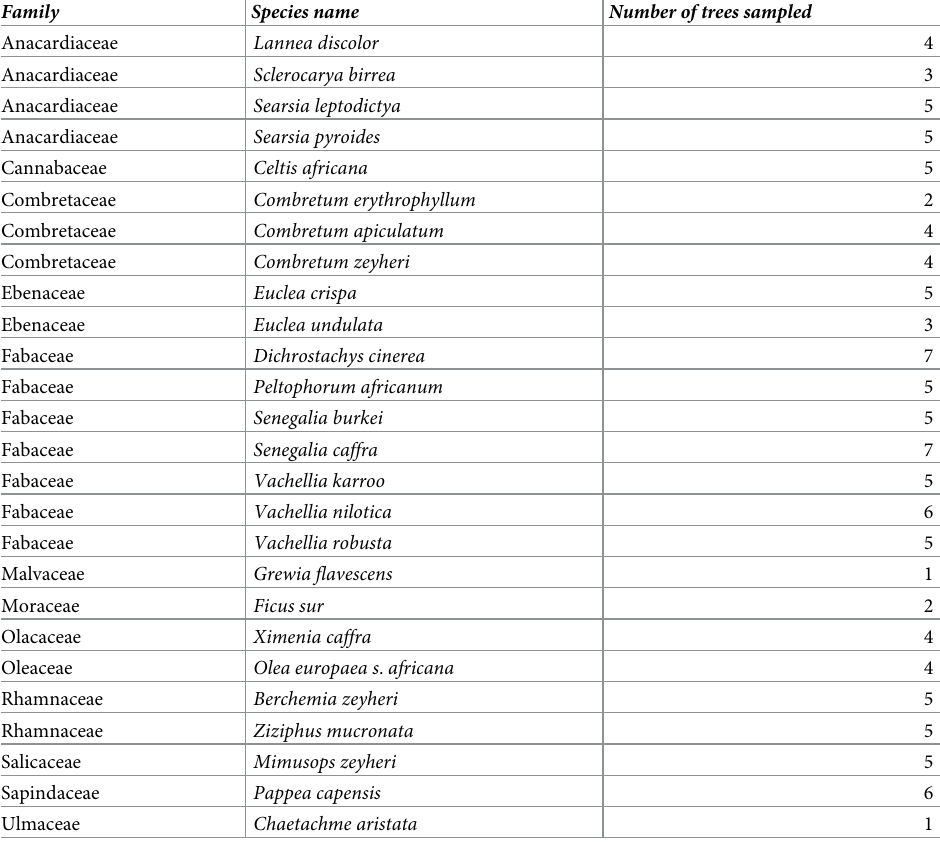
Table 1. Family names, species names and numbers of trees sampled for each species in this study. Family Species name Number of trees sampled